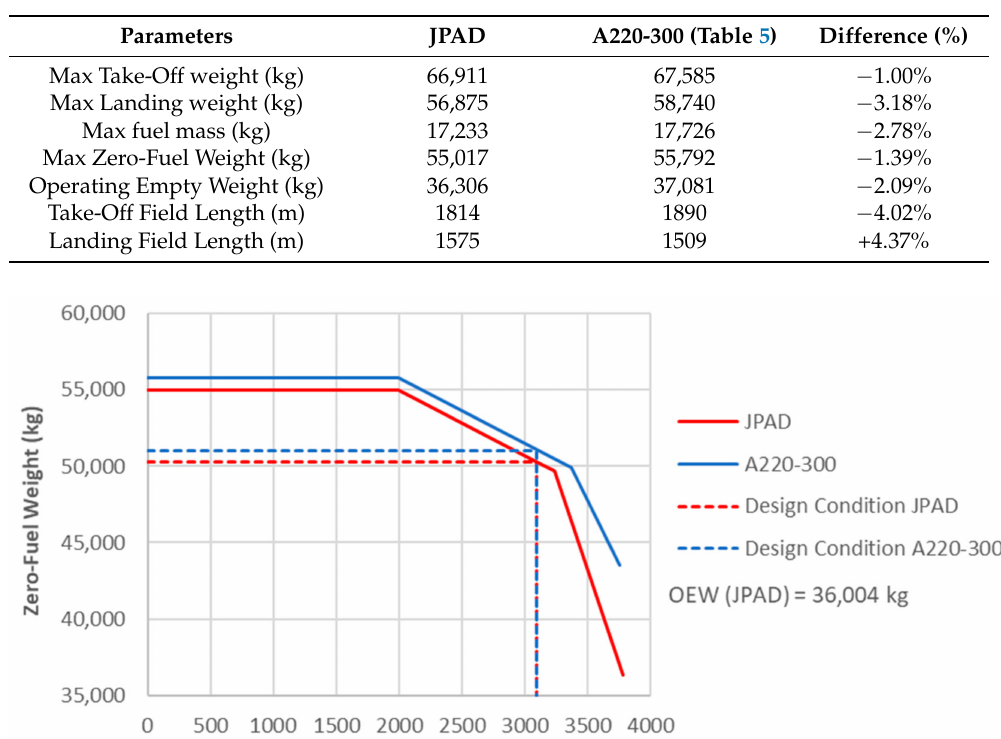
Table 6. Comparison between JPAD output and A220-330 data in Table 5.